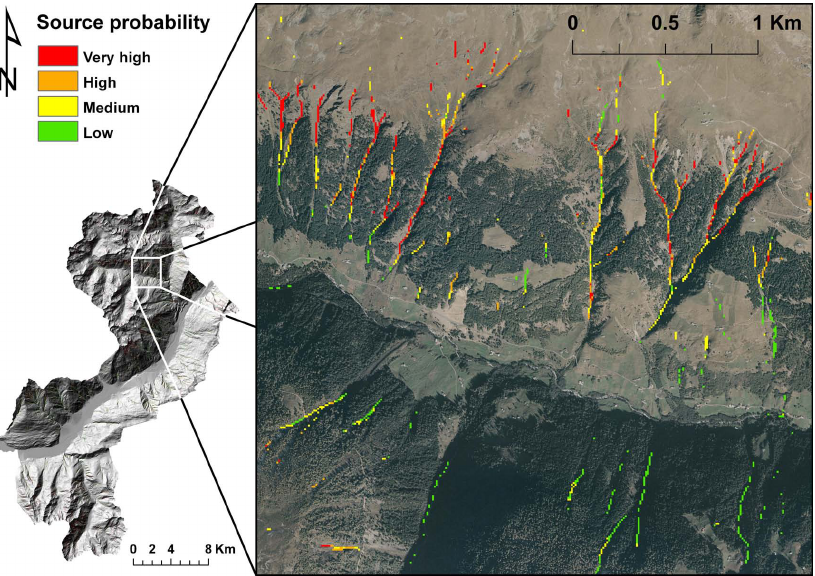
Fig. 6. Example of a source map derived from the Flow-R modelling. Four highest hazard initiation classes together with empirical observations were used to calculate this